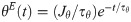
Finite-size induced switching in a bistable network.(A) Schematic of a winner-take-all network architecture: Two competing excitatory populations (NE1 = NE2 = 400) interact with a common inhibitory population (NI = 200). (B)-(D) In the absence of adaptation (θE/I(t) ≡ 0), the excitatory populations switch between low and high activities in an irregular fashion (B). Activities in (B, E) are low-pass-filtered by a moving average of 100 ms. Top: full network simulation. Inset: Magnified view of the activities for 1 s (without moving average) showing fast large-amplitude oscillations. Bottom: mesoscopic simulation. (C) The power spectrum of the activity of the excitatory populations exhibits large low-frequency power and a high-frequency peak corresponding to the slow stochastic switching between high- and low-activity states and the fast oscillations, respectively. (D) The density of the dominance times (i.e. the residence time in the high-activity states) has an exponential form. (E-G) Like (B-D) but excitatory neurons exhibit weak and slow adaptation (θE(t)=(Jθ/τθ)e-t/τθ with Jθ = 0.1 mV⋅s, τθ = 1 s for t ≥ tref). Switching between high- and low-activity states is more regular than in the non-adapting case as revealed by a low-frequency peak in the power spectrum (F) and a narrow, unimodal density of dominance times (G). In (C, D) and (F, G) microscopic and mesoscopic simulation correspond to cyan symbols/bars and dark blue solid lines, respectively. Parameters: μE/I = 36 mV except for μE = 36.5 in (E-G) to compensate adaptation. Time step Δt = 0.01 ms (microscopic), Δt = 0.2 ms (mesoscopic). Efficacies of excitatory and inhibitory connections: wE = 0.0624 mV and wI = −0.2496 mV (B-D), and wE = 0.096 mV and wI = −0.384 mV (E-G), p = 1, ΔuE/I=2.5 mV.